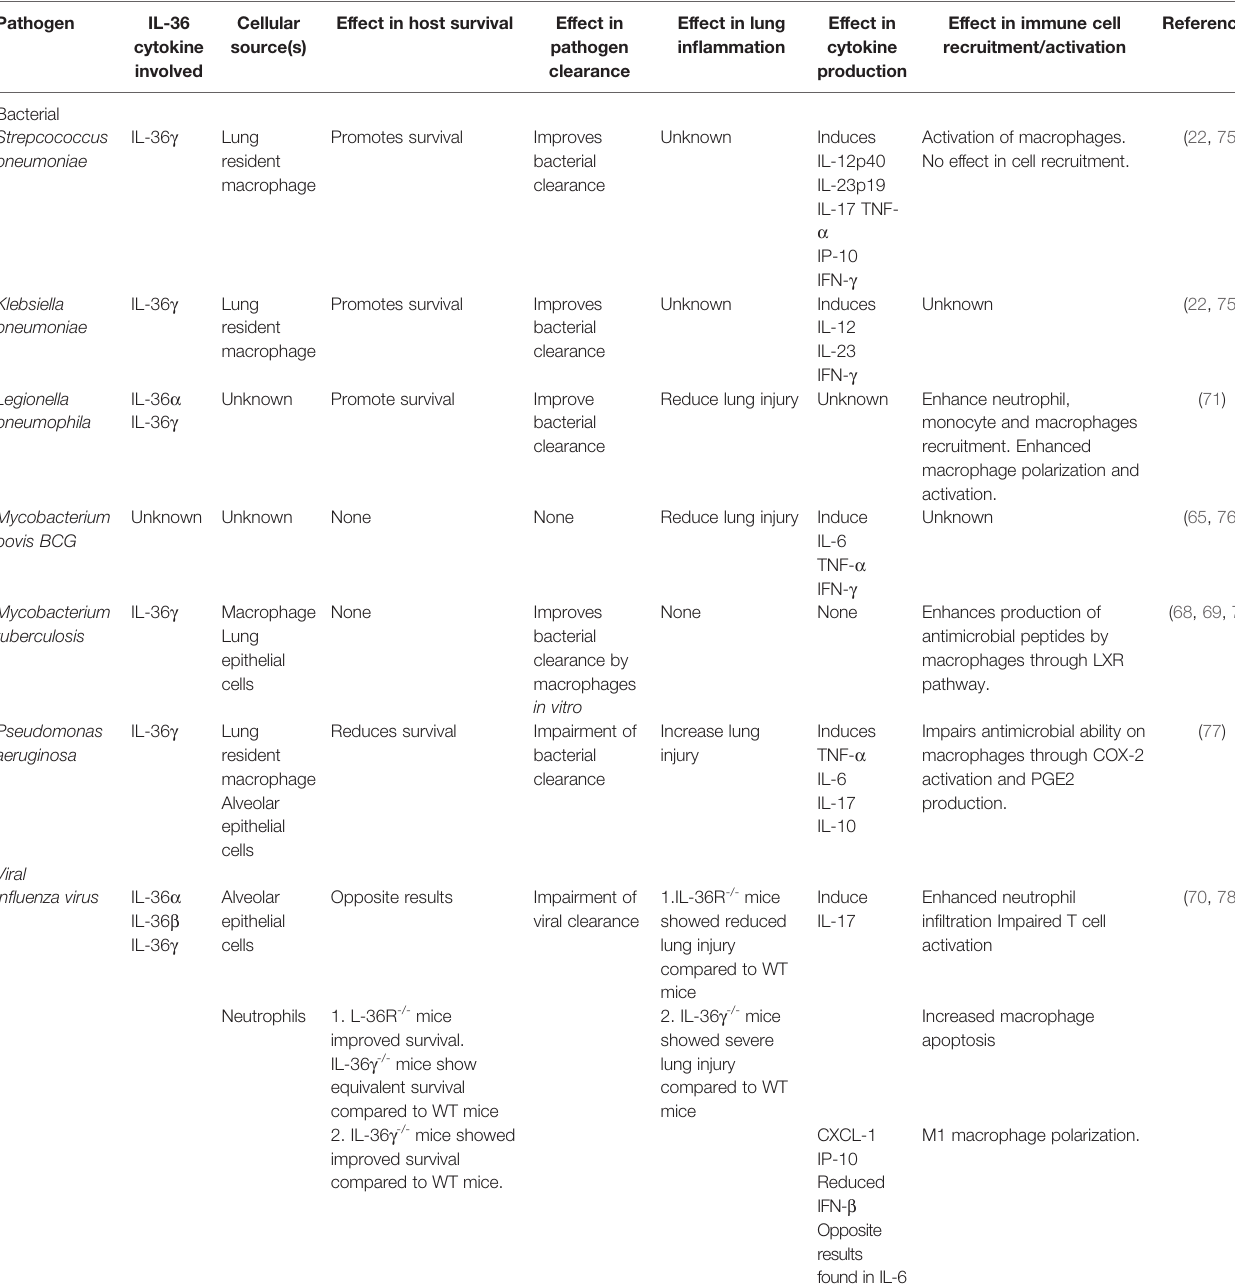
TABLE 2 | Role of IL-36 cytokines during lung bacterial and viral infection and their effect in lung immunity and host